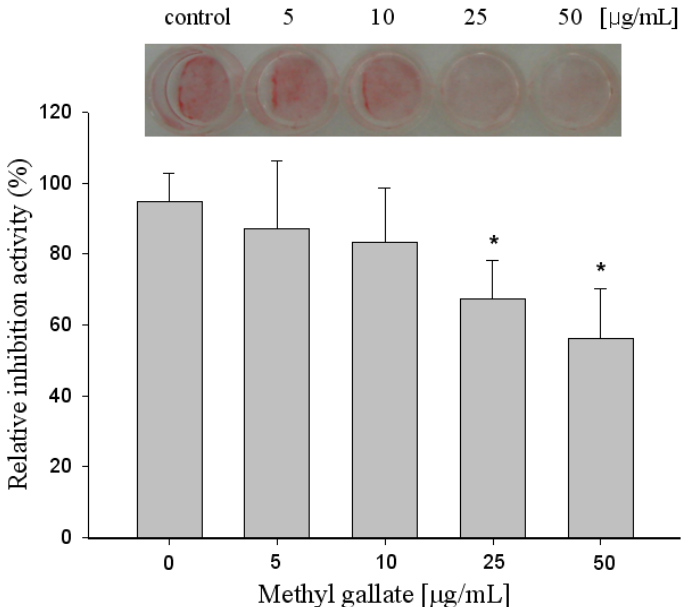
Figure 4. Effects of methyl gallate on lipid inhibition in 3T3-L1 cells. The cells were differentiated with 0, 5, 10, 25, 50 μ g/mL of methyl gallate treatment for 8 days and relative inhibition activity by quantification method of Oil Red O staining was examined. Values are expressed as mean ± standard deviation of at least three independent from that of the control treatment. * p < 0.01.